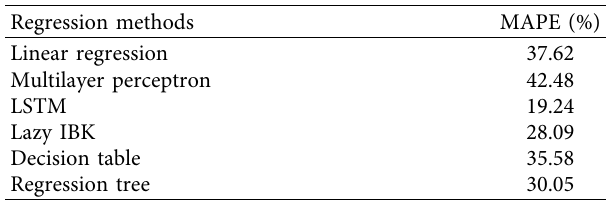
Figure 5: Distributions of the errors of (a) linear regression, (b) LSTM, and (c) regression tree. Table 3: The MAPE of different methods for wind power forecasting.